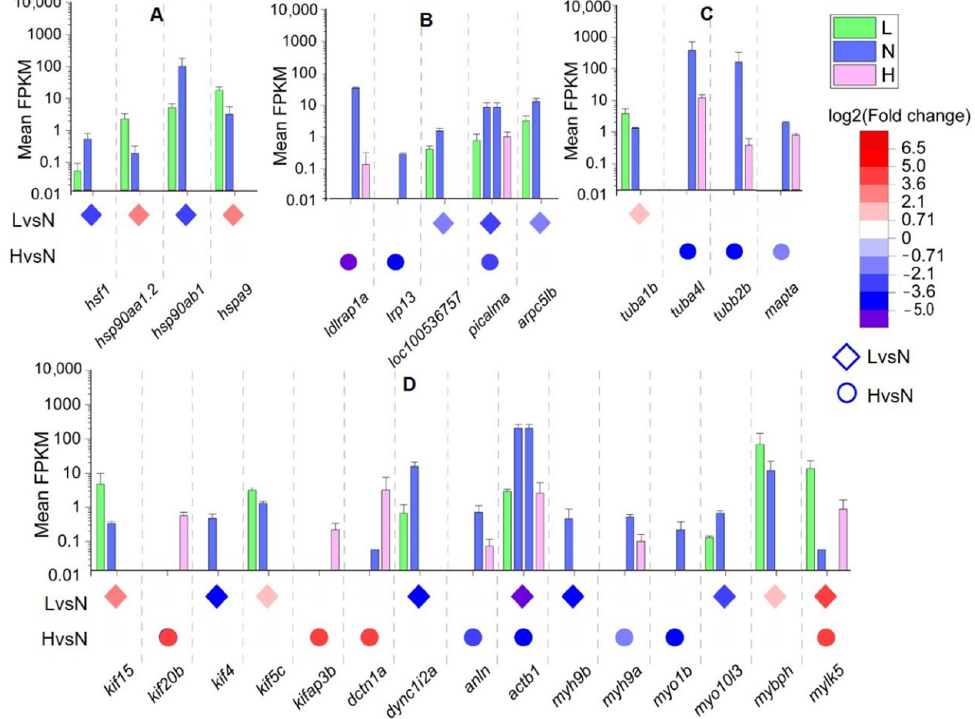
Figure 5. Expression level and relationship between upregulated and downregulated key DETs. The circle and square represent the fold-change in the expression of DETs in the LvsN and HvsN temperature conditions, respectively. The DETs of ( A ) heat stress, ( B ) VtgRs and endocytic transports, ( C ) microtubule, and ( D ) motor proteins. Note: The expression levels of DETs are indicated with the gene names for the LvsN and HvsN comparisons ( n = 3).